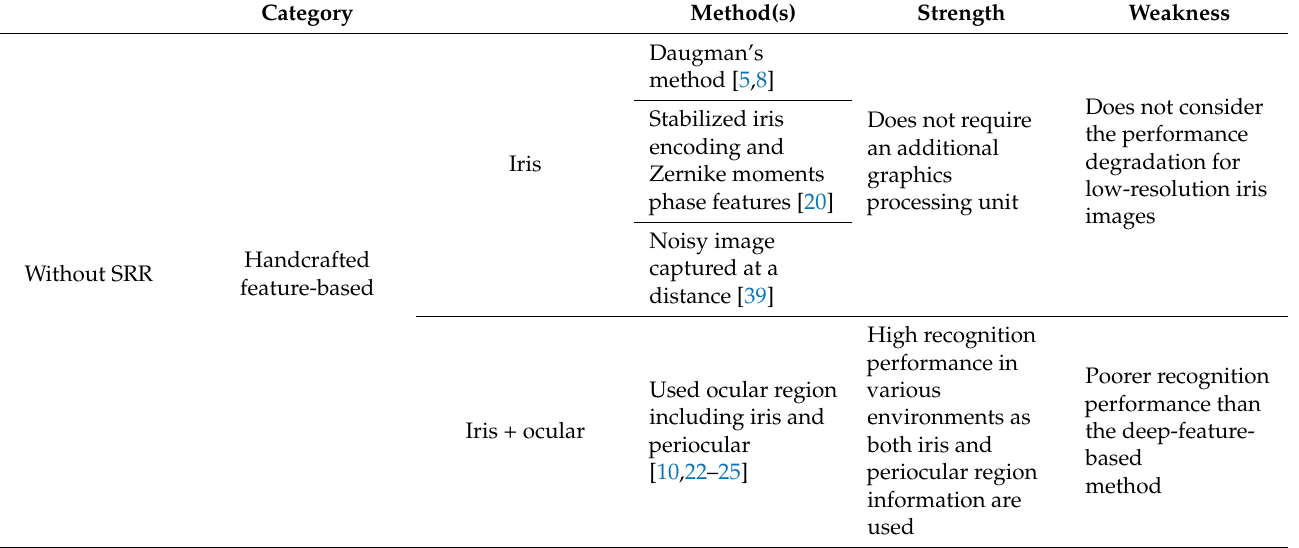
Table 1. Comparisons of previous studies and the proposed